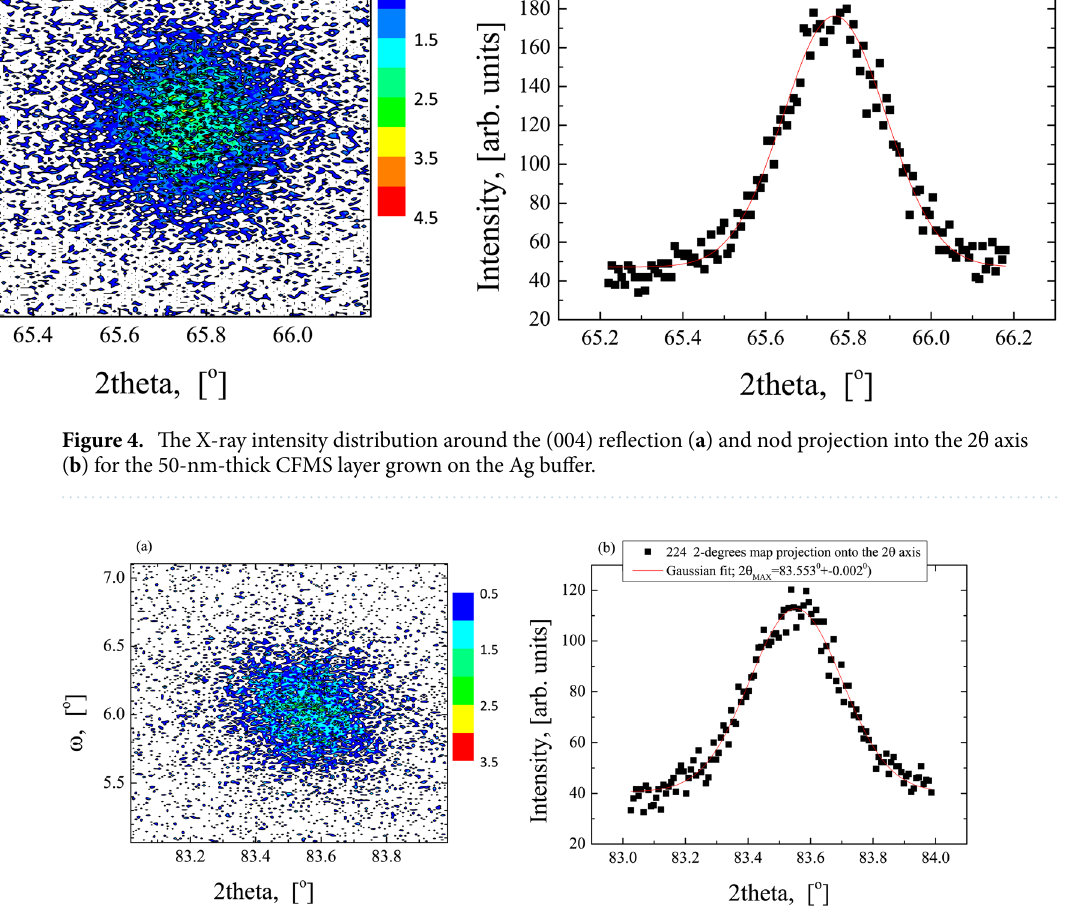
Figure 5. The X-ray intensity distribution around the (224) reflection ( a ) and nod projection into the 2θ axis ( b ) for the 50-nm-thick CFMS layer grown on the Ag